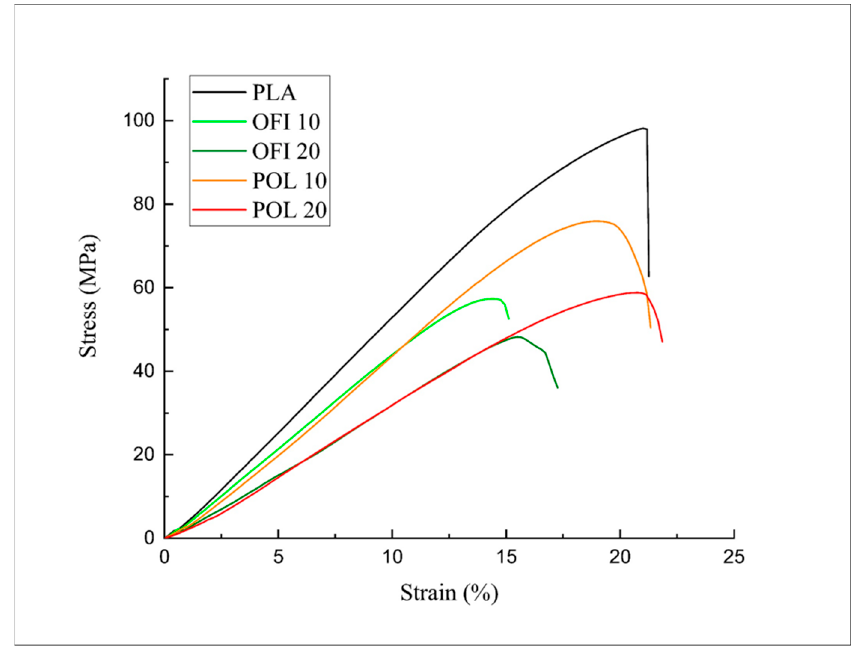
Figure 13. Stress–strain curves of the investigated systems (flexural tests).